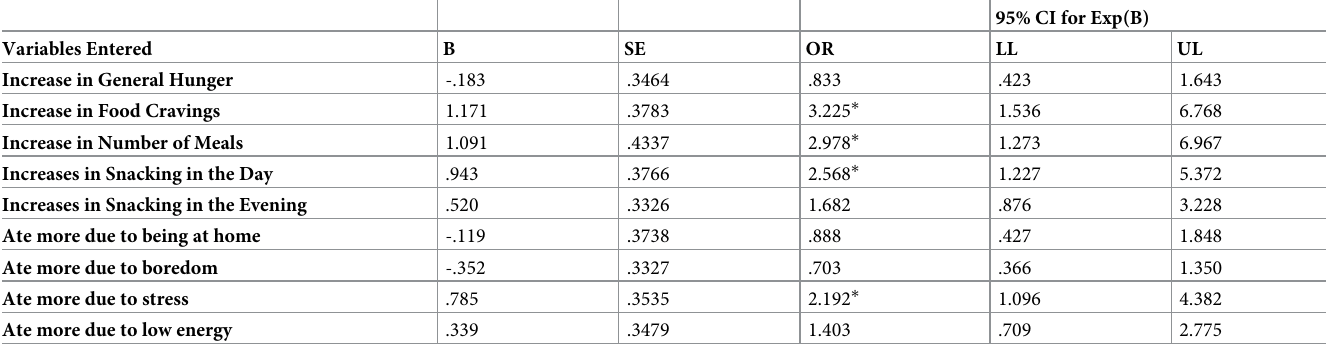
Table 4. Coefficients of the predictive model for weight